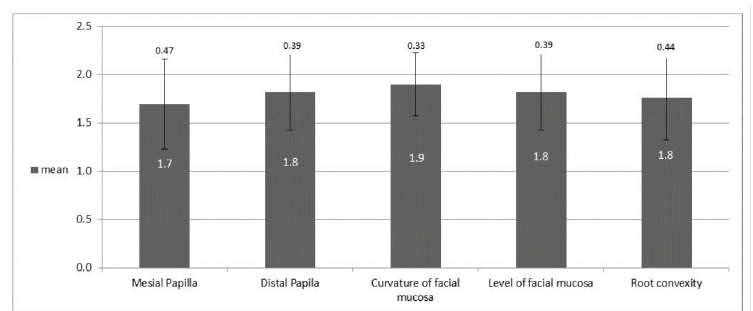
Figure 1. Mean PES value of each parameter indicating a good pink esthetic result.